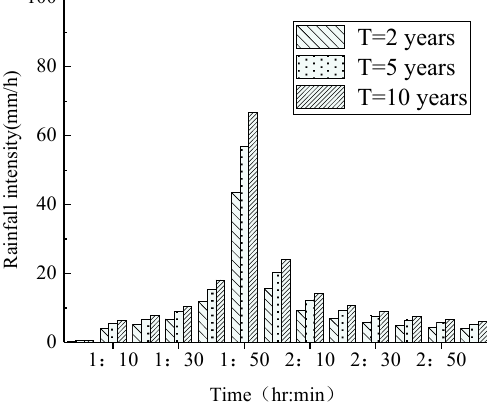
Figure 4. Design rainfall hyetographs at the study area.